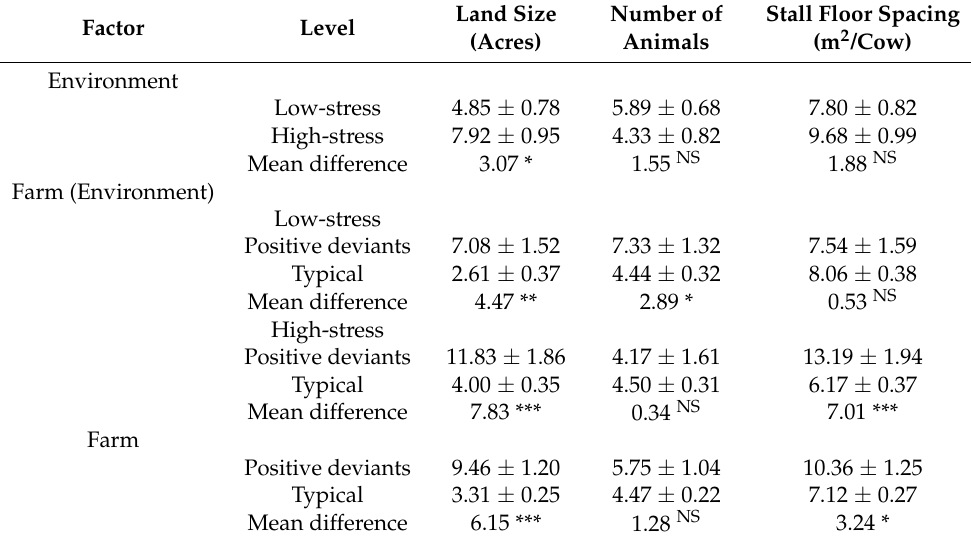
Table 1. Means (mean ± SE) of land size, the number of animals and stall floor spacing per cow in positive deviants and typical farms under contrasting